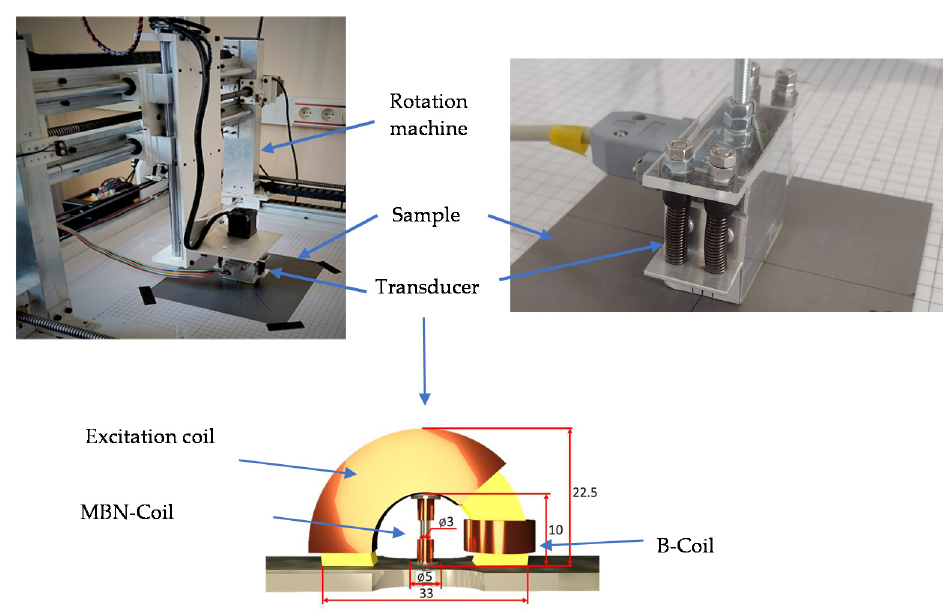
Figure 1 . View of the rotation machine with sample and transducer (with dimensions given in mm). Conventional (CGO) and high grain-oriented (HGO) steel grades were utilized for sample preparation. The steel sheets had different thicknesses of 0.23 mm, 0.27 mm and 0.30 mm, and were subjected to various surface engineering methods, including coating with and decoating of oxide layer, laser scribing of the surface or nitriding. A detailed erties, can be found in the previous paper [26]. The set of the inspected samples with their basic description is given in Figure 2.